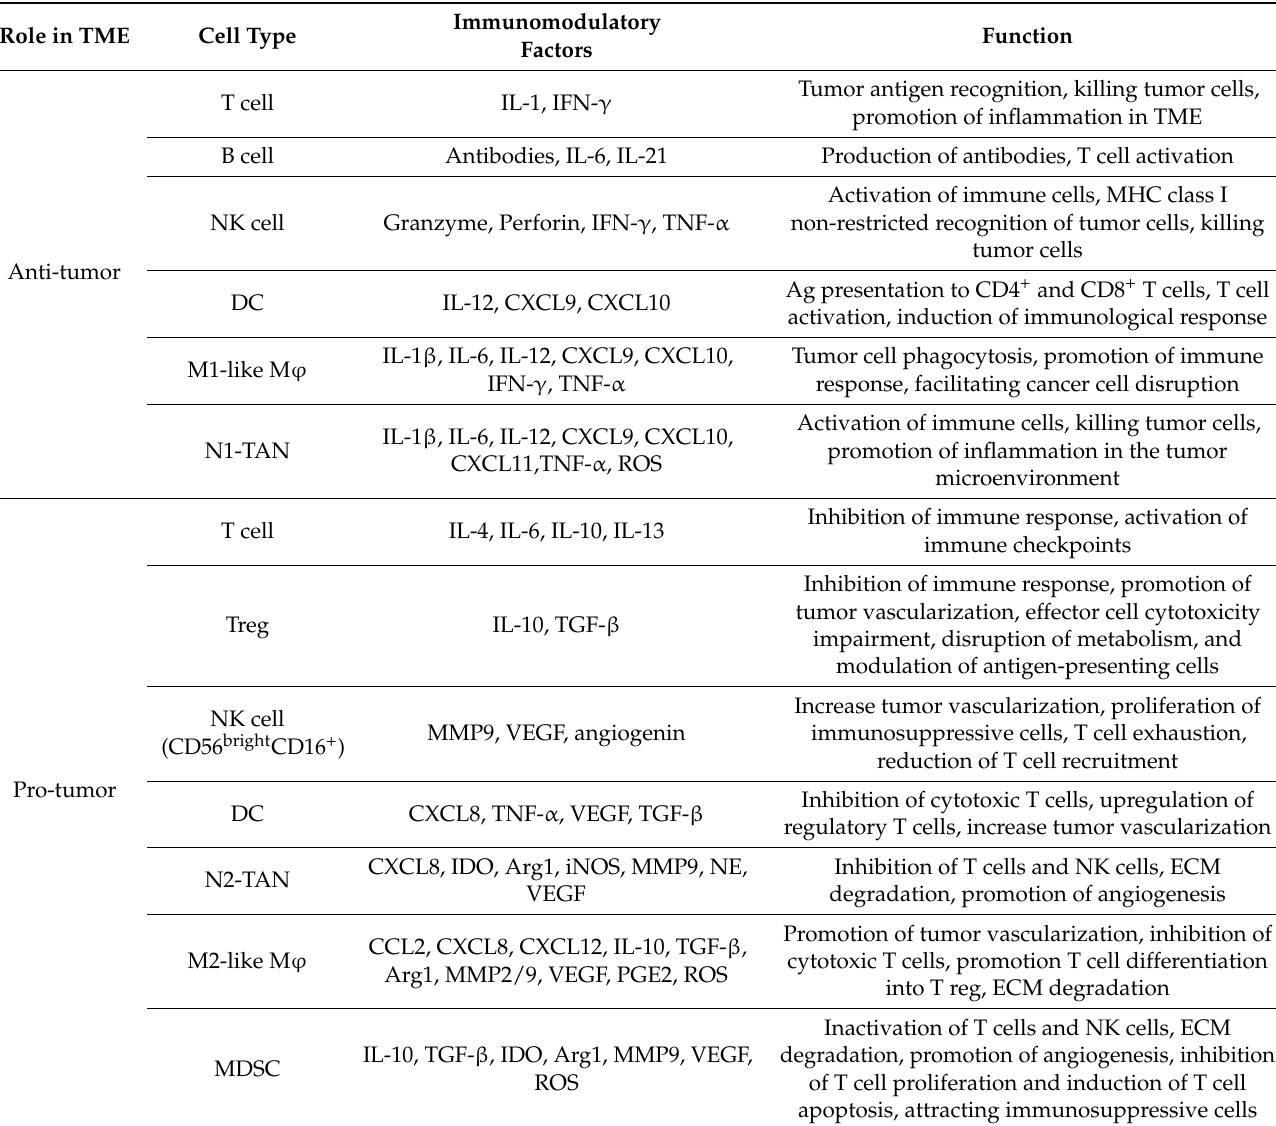
Table 1. Immune cells, immunomodulatory factors and their function in the